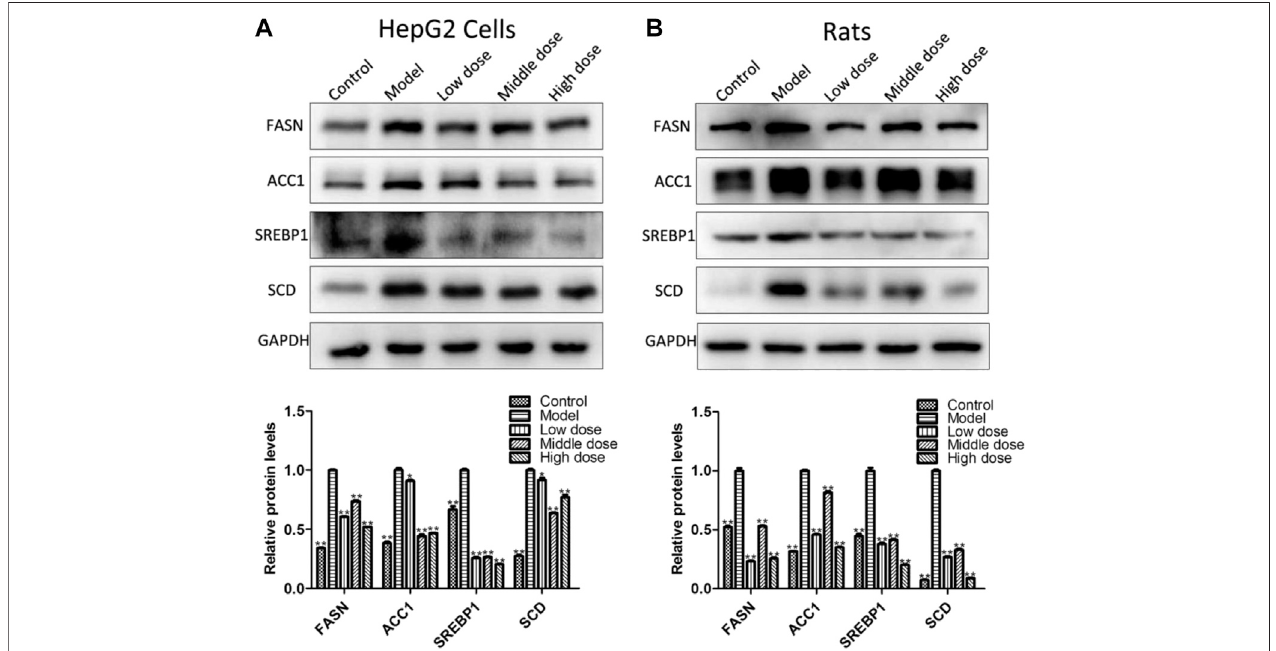
FIGURE 5 | Effect of aromatic vinegar on the levels of some proteins related to lipid metabolism. (A) Effects of aromatic vinegar on the protein levels of fatty acid synthase(FASN),acetyl-CoA carboxylase-1(ACC1),sterolregulatory elementbindingtranscriptionfactor1(SREBP1)andstearoyl-CoAdesaturase-1 (SCD) invitro ; (B) Effects of aromatic vinegar on the protein levels of FASN, ACC1, SREBP1 and SCD in vivo . Values are expressed as the mean ± SD (n (cid:2) 3). * p < 0.05, ** p < 0.01 compared with model groups.